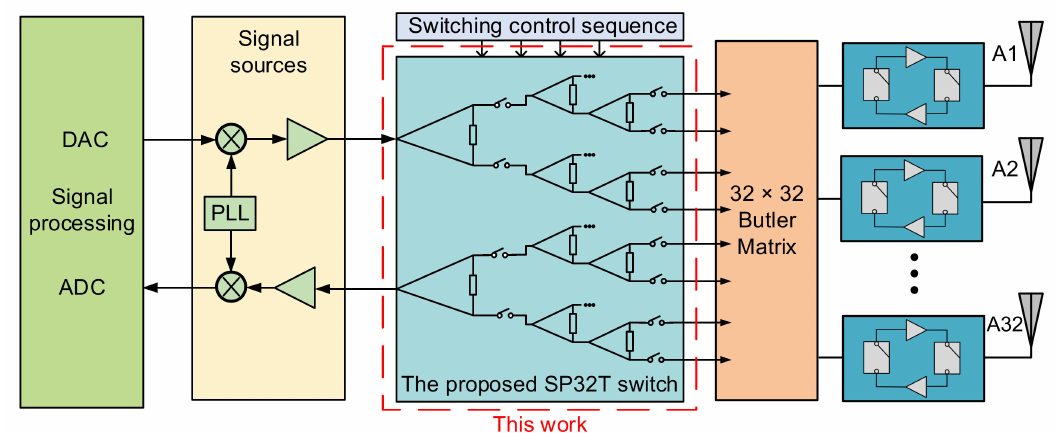
Figure 4. The sub-6 GHz 5G communication system structure using the proposed SP32T switches. DAC: digital-to-analog converter; ADC: analog-to-digital converter.